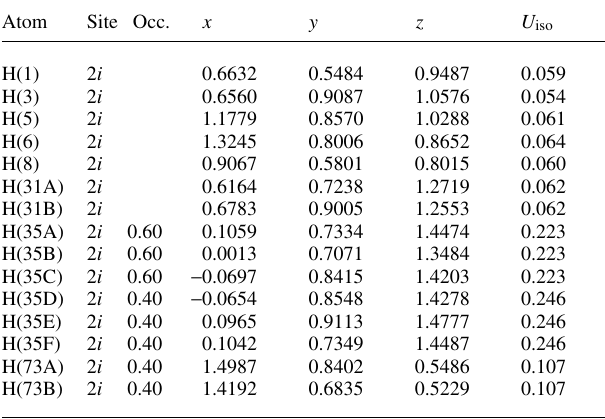
Table 2. Atomic coordinates and displacement parameters (in Å 2 )